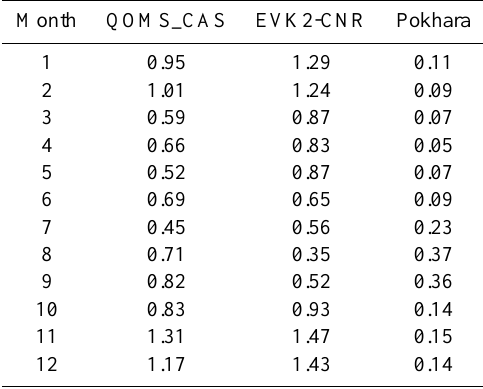
Table 2. The monthly median uncertainties in Angström exponent 440–870nm at QOMS_CAS, EVK2-CNR and